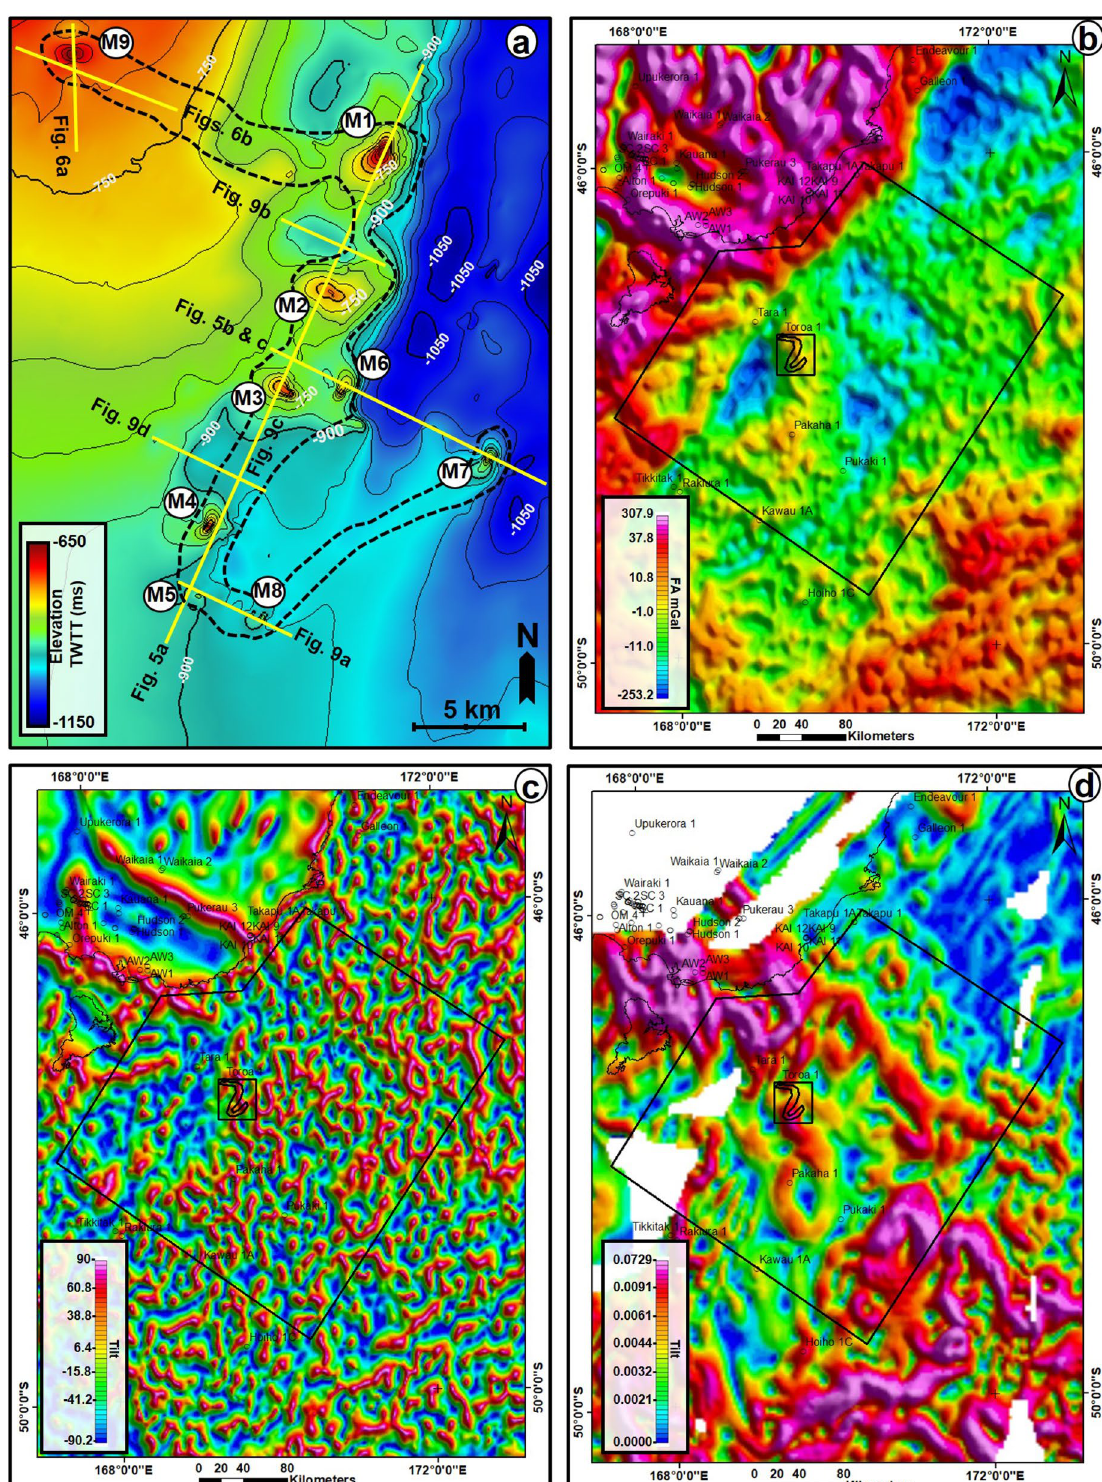
Figure 4. ( a ) TWTT structural map of the seafloor showing the location of the nine mounds (M1-M9) analyzed in this study. Contour spacing for the map is 30 ms TWTT. TWTT: Two-way travel time in milliseconds. The location of this map is shown in Fig. 1b. The black dashed polygon highlights the stretch of the seafloor mounds, which covers an area of about 186 sq. km. ( b ) Free Air (FA) gravity map over the study area and anomalies shown in ( c ) Tilt filter of the Bouguer corrected Satellite gravity data ( d ) Modulus (MS) of Reduced To Pole Magnetics with a 20 km Low Pass filter. ( b )–( c ) were reprojected in the NZGD2000, NZTM coordinate system (Data source: www. nzpam. govt.